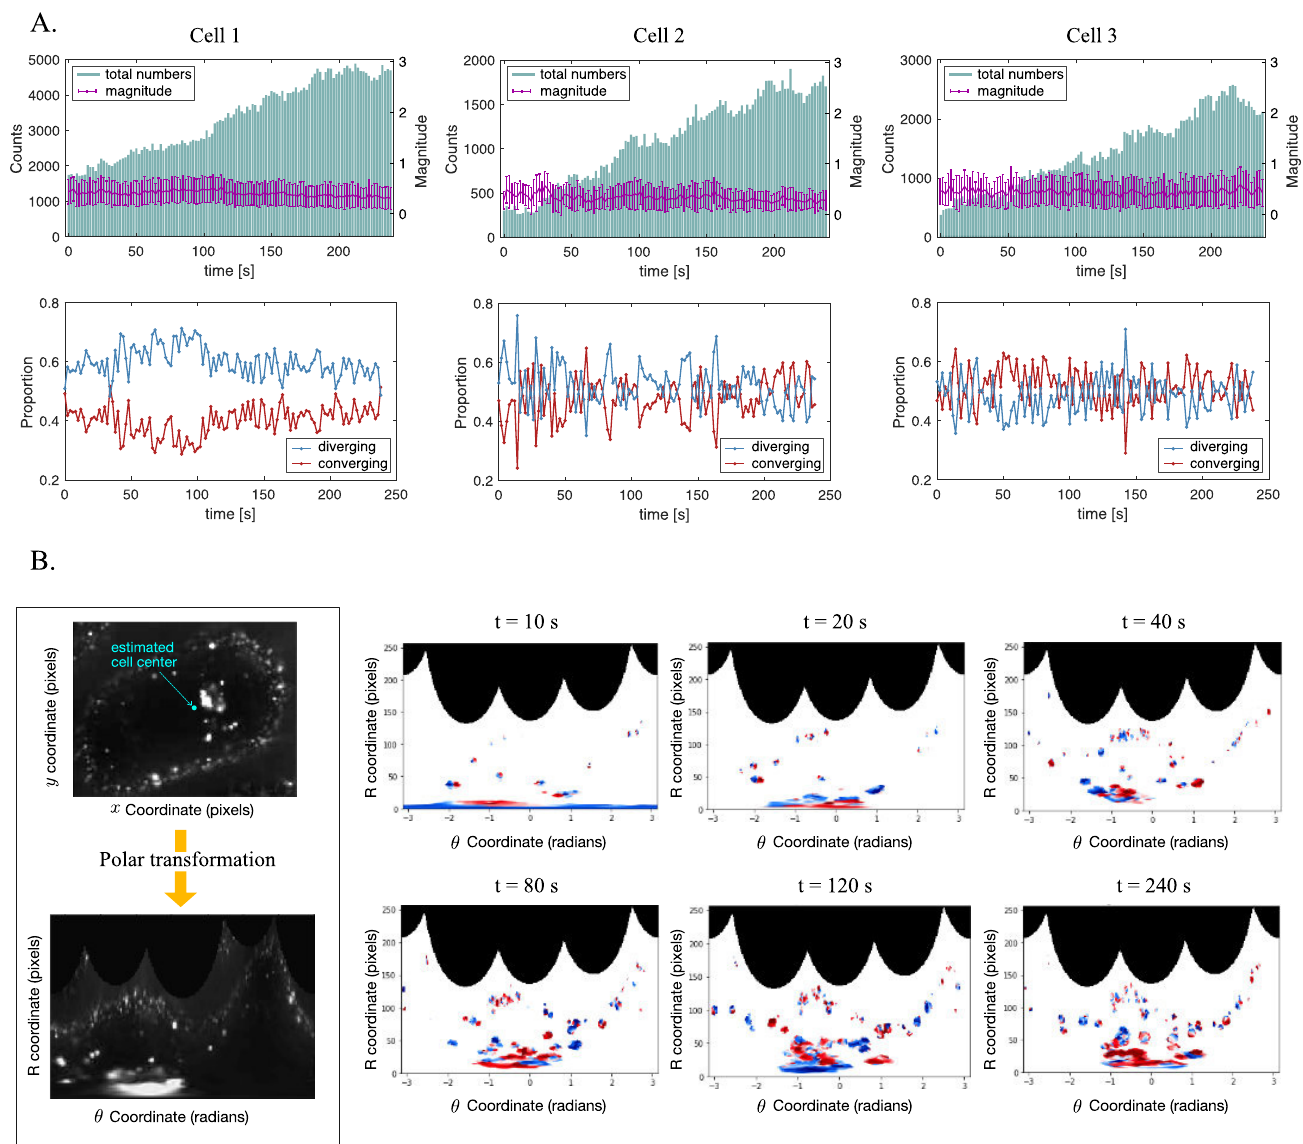
Figure 5. Direction of vesicle movement analysis using the suggested method. ( A ) Total numbers and magnitude of optical flow vectors detected over time for three sample cells (upper) and the proportion of diverging and converging movement over time (lower). ( B ) Polar transformation [44] of cell image to visualize the vesicle movement in terms of the distance from cell center (right). Vesicle movement of inward direction colored in red and outward in blue, after polar transformation is